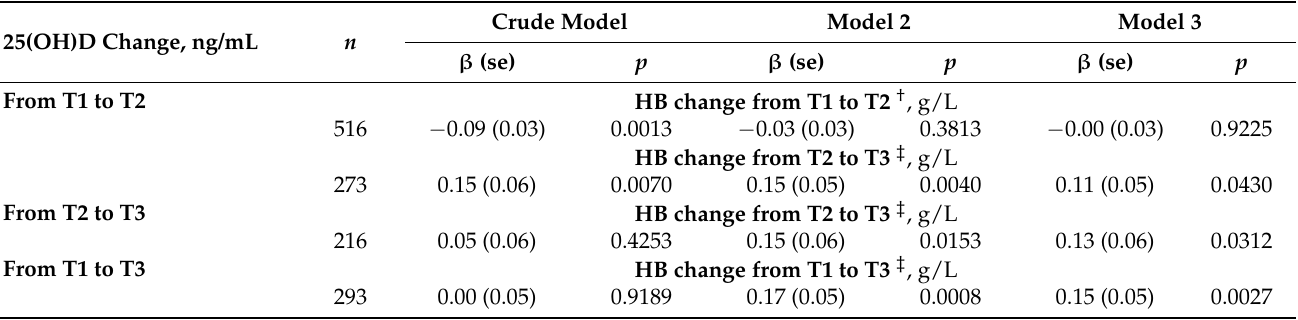
Table 7. The association between plasma 25(OH)D change and hemoglobin change between different